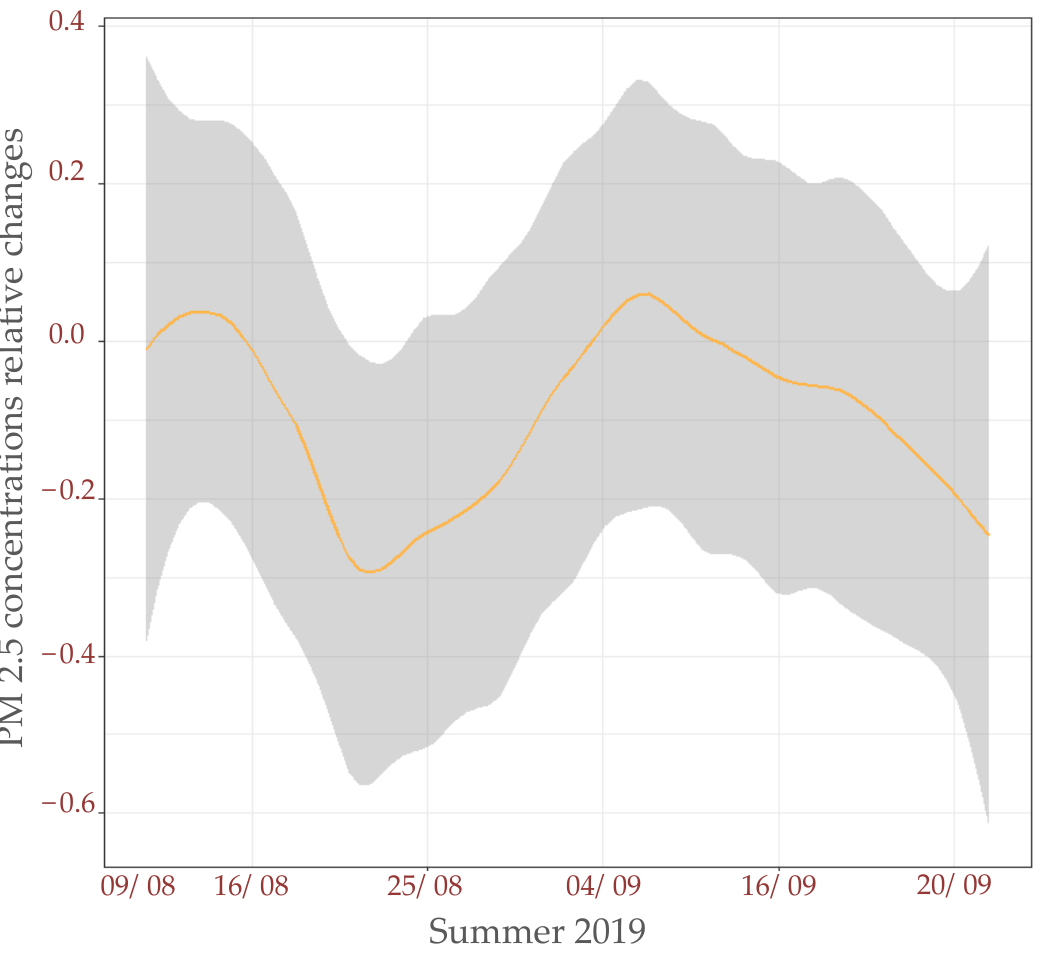
Figure 9. Relative changes calculated from e-PM µ-sensors located in front (traffic side) and behind (opposite side) the flat-top earth berm. We used Equation (9) with as the reference measure the record behind the earth berm.